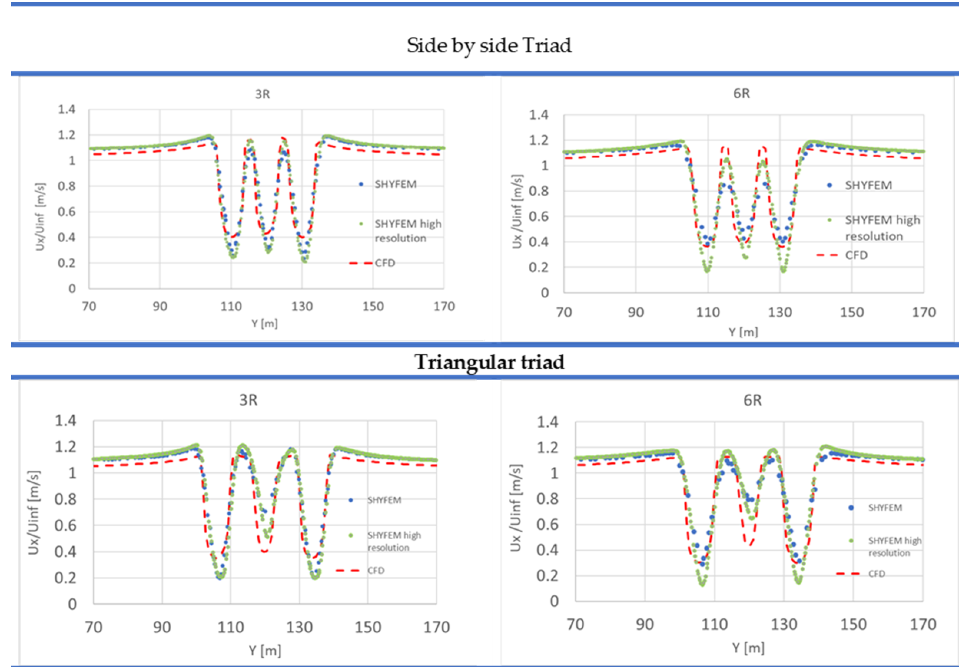
Figure 19. Wake velocity profile at 3 R and 6 R behind the turbine.